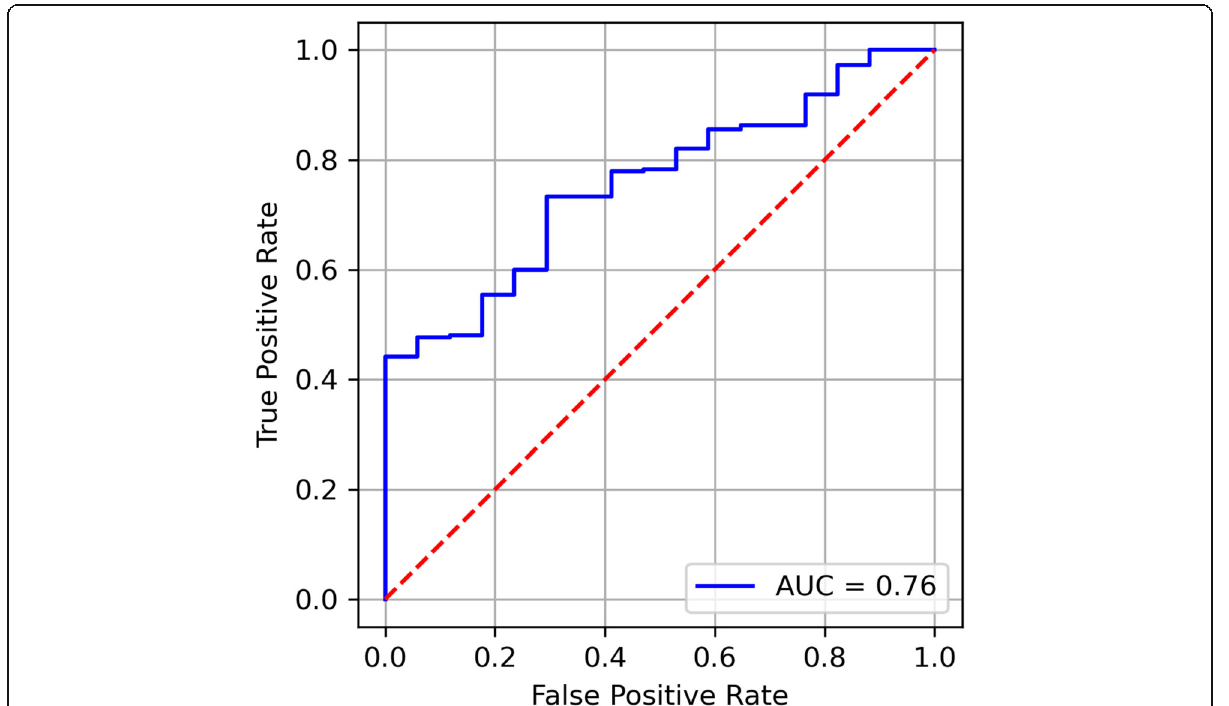
Fig. 1 ROC curve for patient satisfaction using the LASSO model, achieving an AUC of